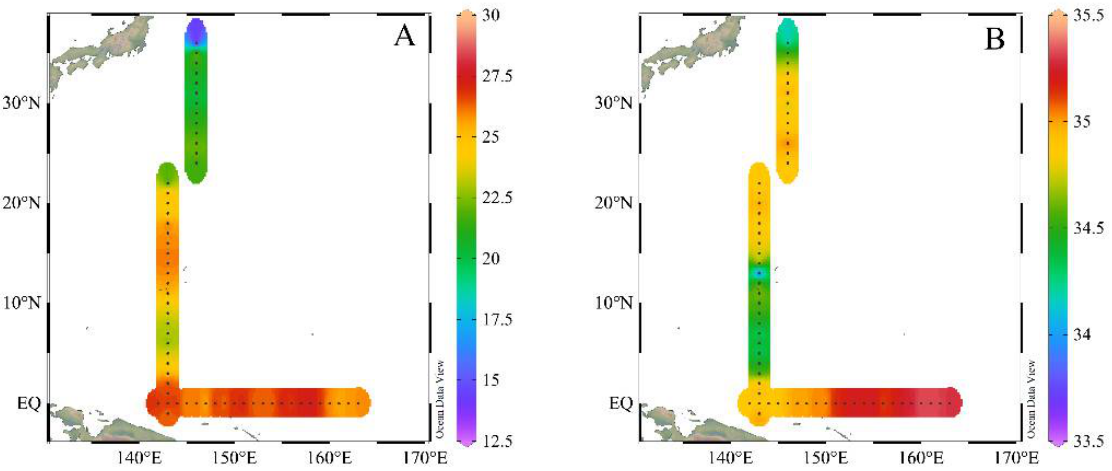
Figure 2. Integral distribution of the water column for temperature and salinity. ( A ) Temperature (°C); ( B ) salinity.